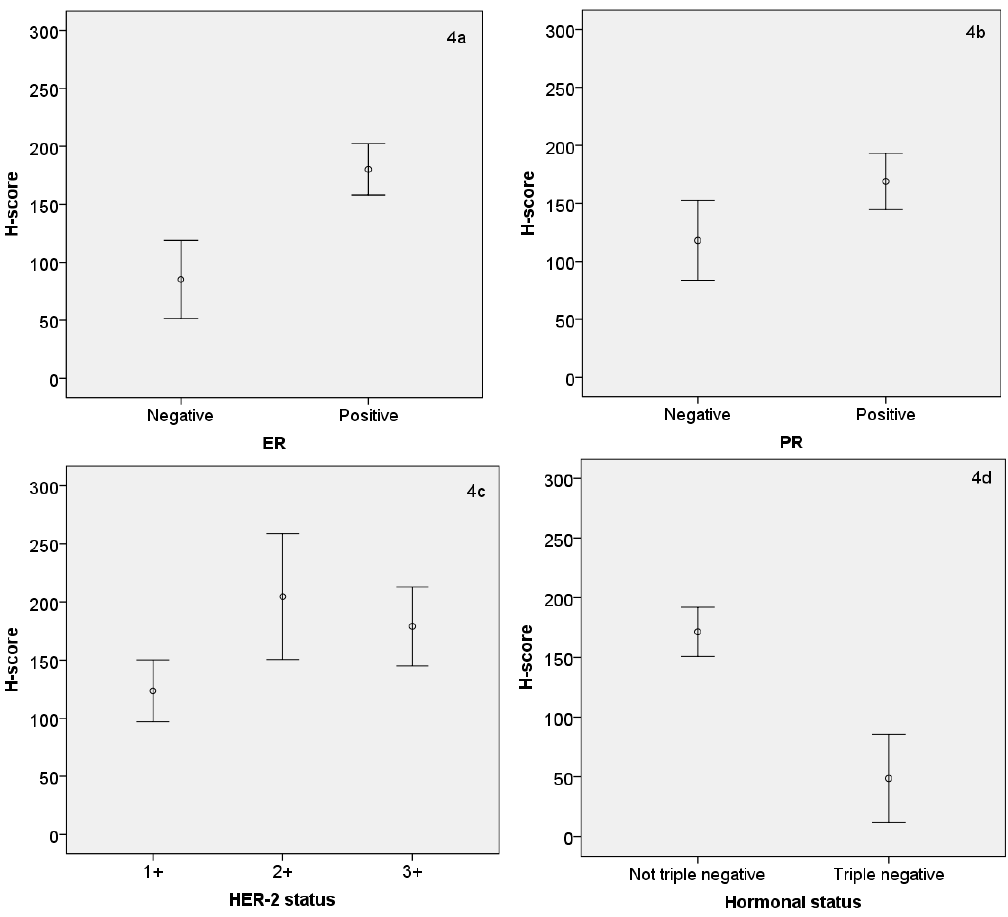
Figure 4. ( a – d ) Error bar graph showing the mean ± standard error (S.E.) of androgen H ‐ score by ER,